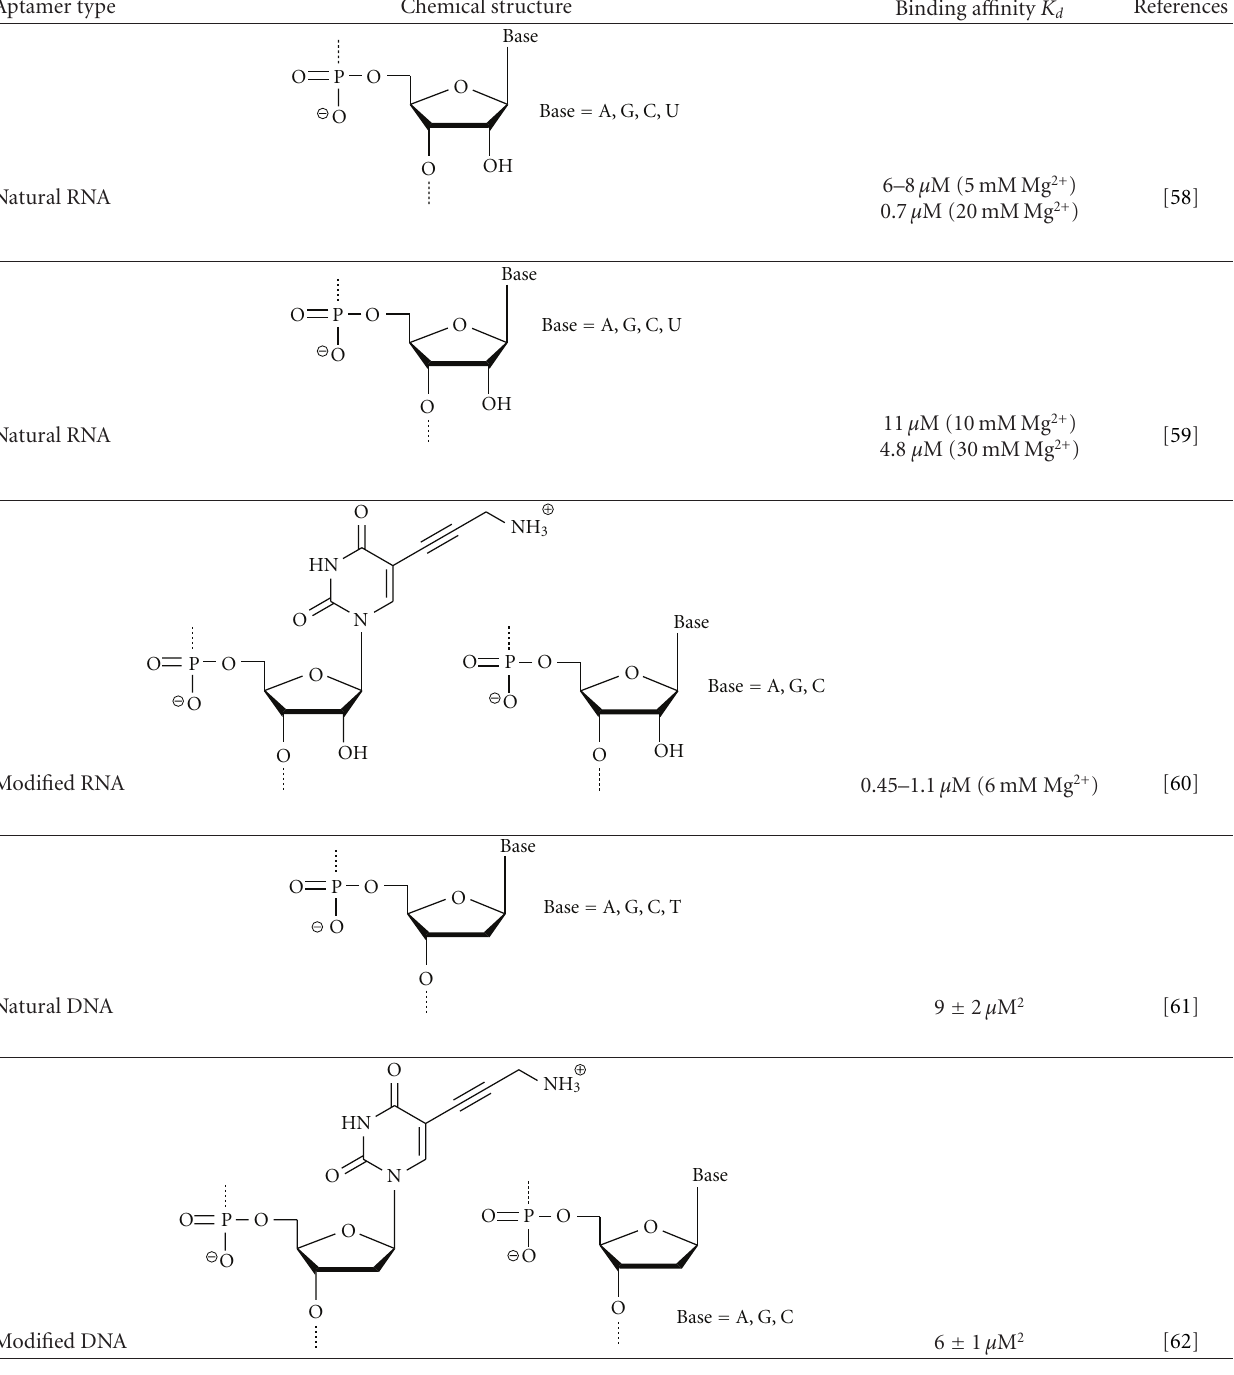
Table 1: Comparison of binding a ffi nities in ATP-binding natural/modified nucleic acid